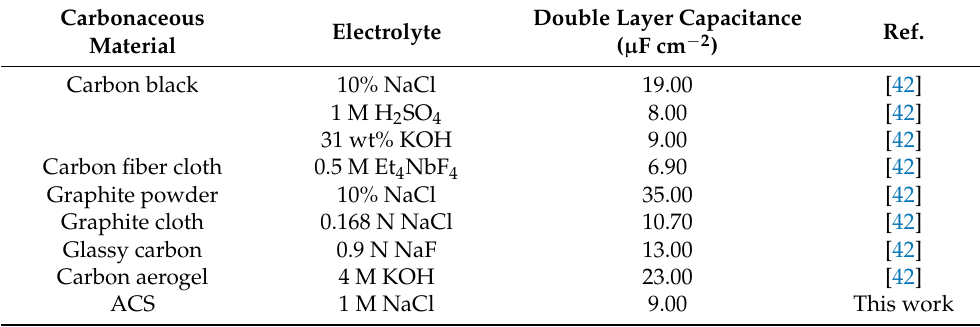
Table 6. Values of electrochemical double layer capacitance of carbonaceous materials as found in